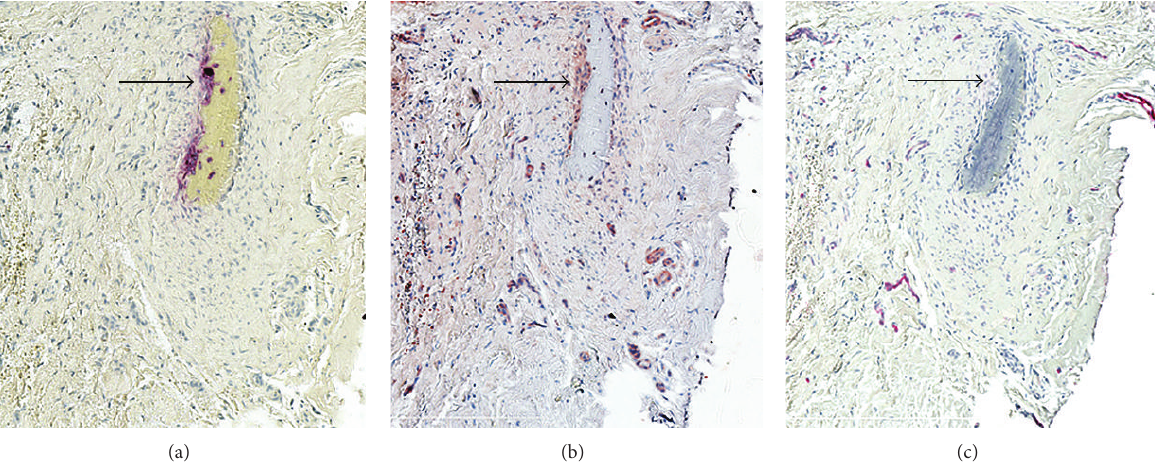
Figure 3: Expression of osteoclast and vascular-associated molecules in mildly inflamed gingival tissues. (a) TRAP (osteoclast marker), (b) OSCAR C. Von Willebrand factor to identify the microvasculature. The magnification was